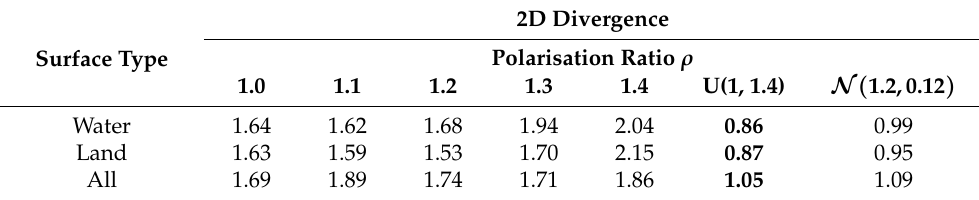
Figure 3. The polarisation differences (166V − 166H) as a function of brightness temperatures at 166V GHz (PD-TB V relationship) over ( a ) water and ( b ) land. The GMI observations are shown in dark grey, while the other colours represent the simulations for different values of ρ . The three overlaid lines represent the 5th, 50th and 95th percentiles of the observed polarisation differences for each TB interval. The simulations were based on large plate aggregate. The data affected by the surface were filtered out (see text). The simulations were from January 2009 and the observations were from January 2017. Table 3. The 2D divergence describing the differences between the observations and simulations over water, land and all surface types. The results from the five experiments with different values of ρ , uniform distribution ( ρ ∈ U(1.0, 1.4)) and truncated normal distribution ( ρ ∈ N ( 1.2,0.12 ) ) are shown. The lowest divergences are highlighted in